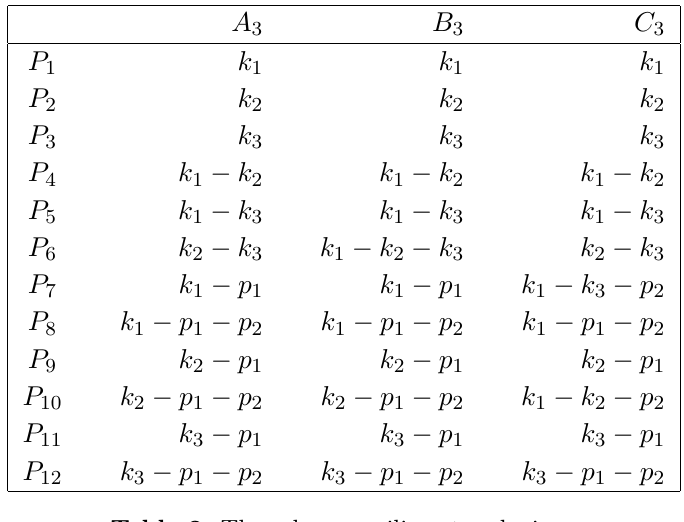
Table 2 . Three-loop auxiliary topologies.